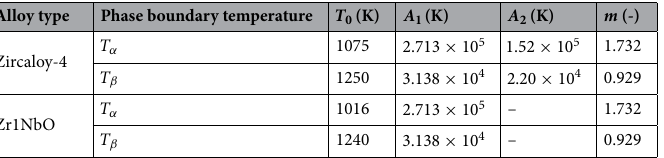
Table 2. Constants for calculating phase boundary temperatures of Zircaloy-4 and Zr1NbO cladding through Eq.